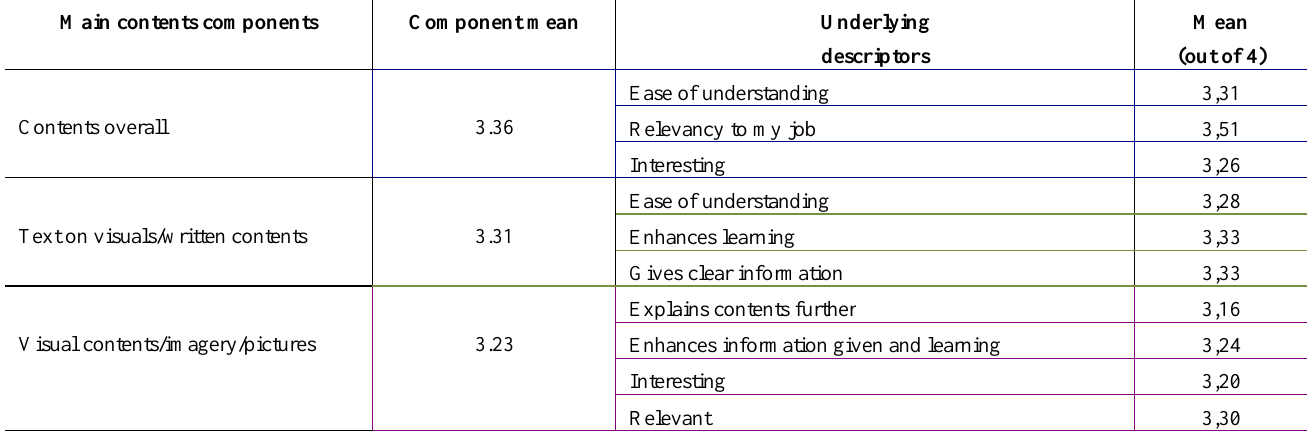
Table 1: Rating of learning contents of ID model